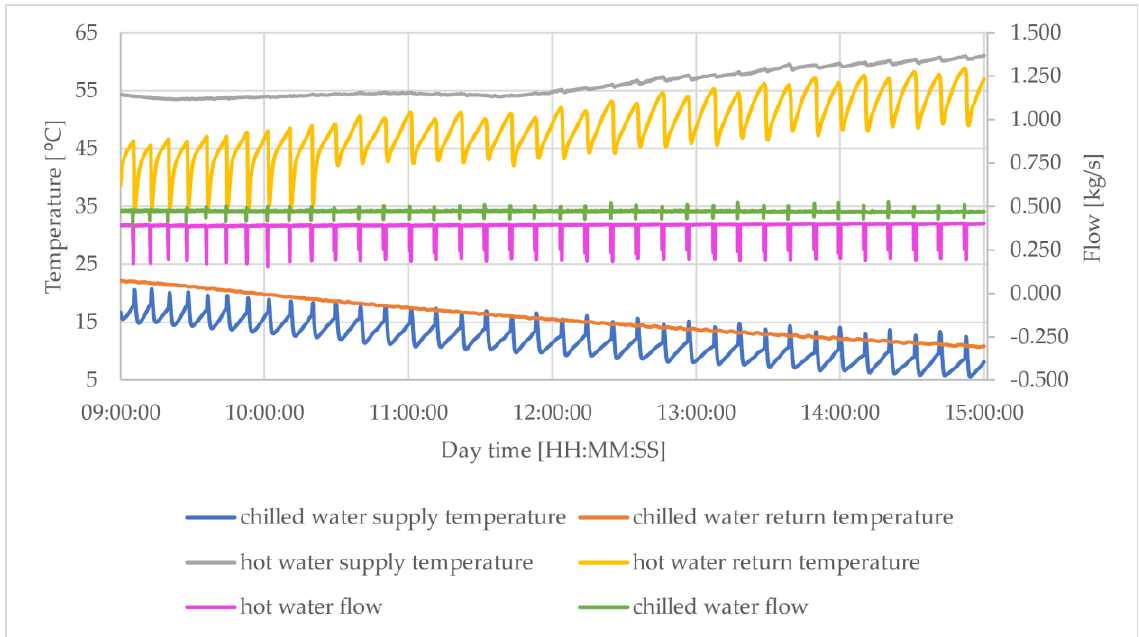
Figure 6. Measured values of temperatures and flow rates over time for 22nd July.